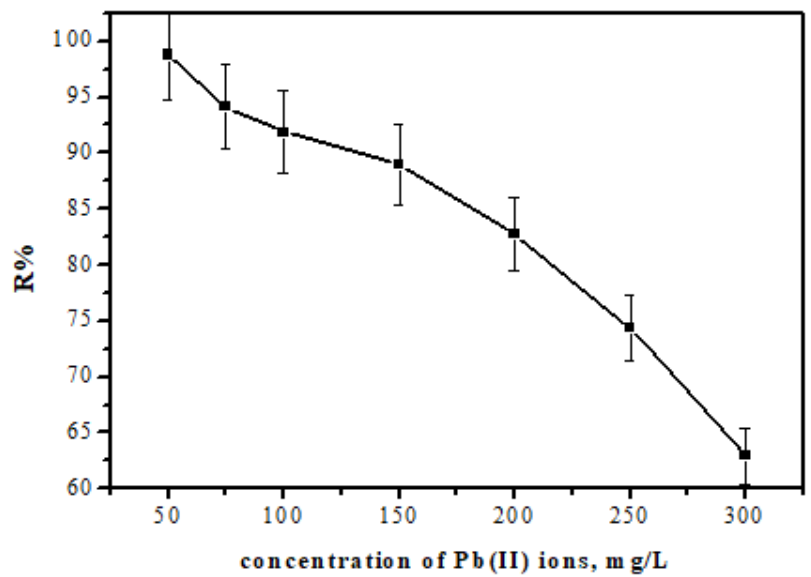
Figure 10. Effect of Pb(II) concentration on the efficiency of the GA/MNP composite for the removal of Pb(II) ions from synthetic wastewater at 298 K.